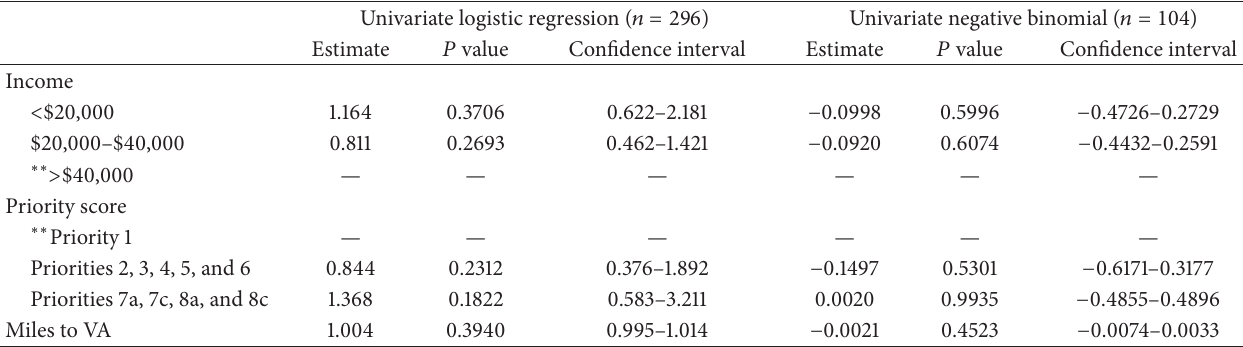
Table 5: Enabling factors ∗ for veterans’ utilization of inpatient hospitalization.